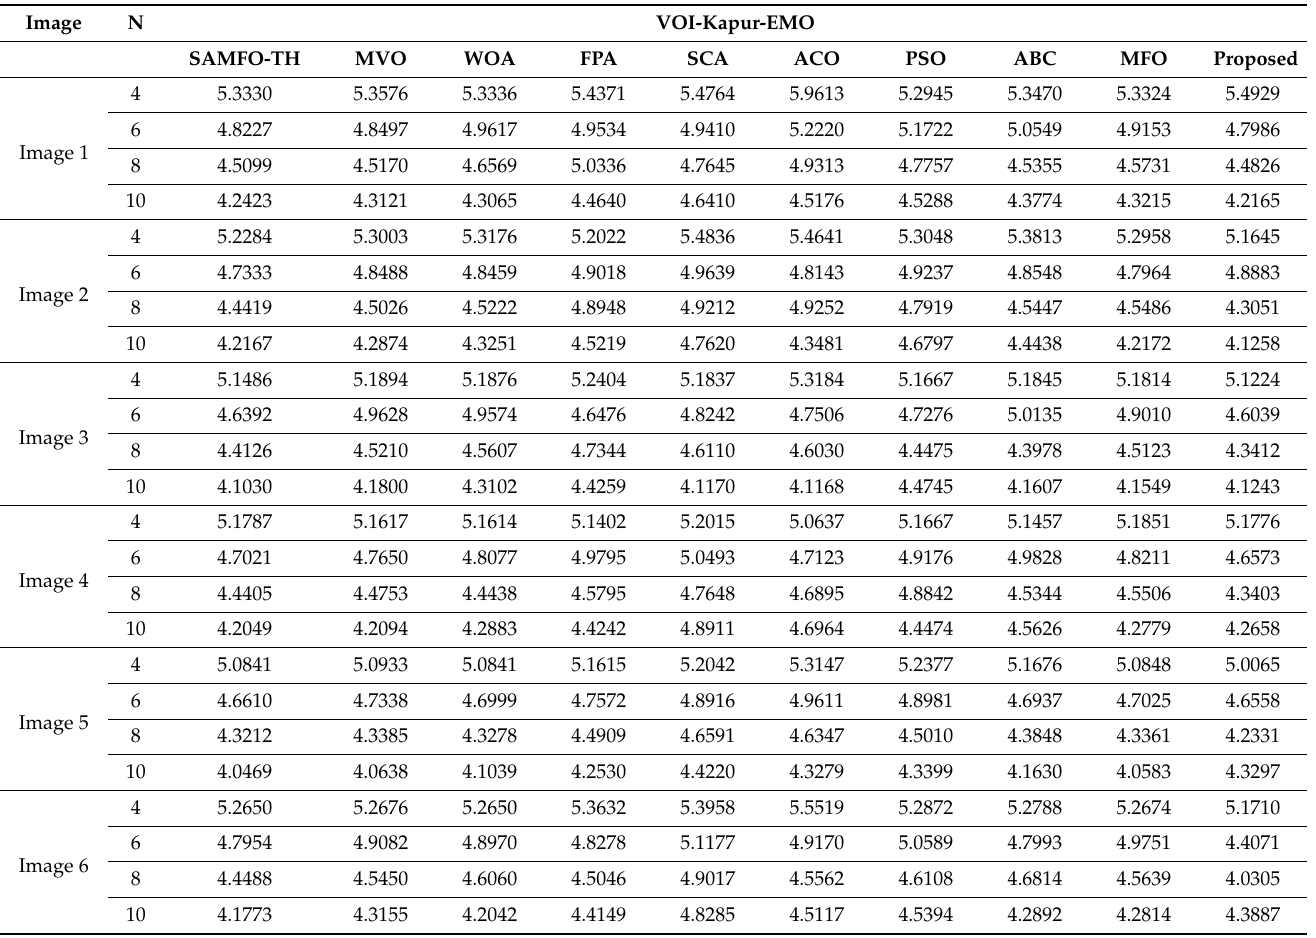
Table 7. Comparison of VOI computed by SAMFO-TH, MVO, WOA, FPA, SCA, ACO, PSO, ABC, and MFO with the proposed model using Kapur’s method with N = 4, 6, 8, and